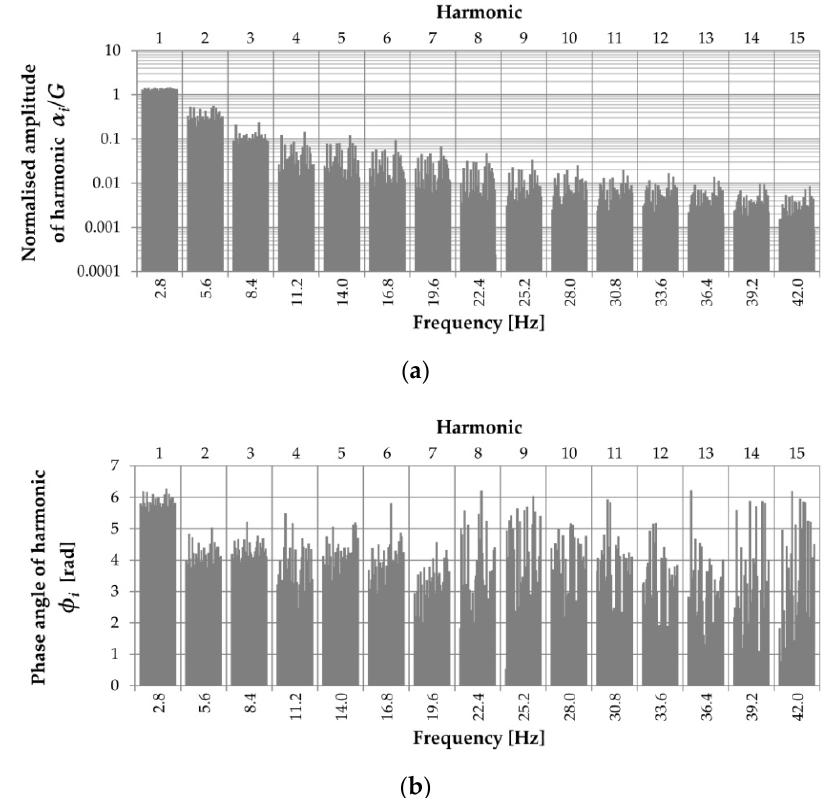
Figure 8. The charts of ( a ) normalised amplitudes (log scale for the φ i -axis) and ( b ) phase angles (linear scale for both axis) of the fifteen harmonics determined for forty F VGRF samples generated by four forefoot-strike runners ( f r = 2.80 Hz) (The data presented can be found in Supplementary Materials in the form of text files containing numerical data. See section Supplementary materials).